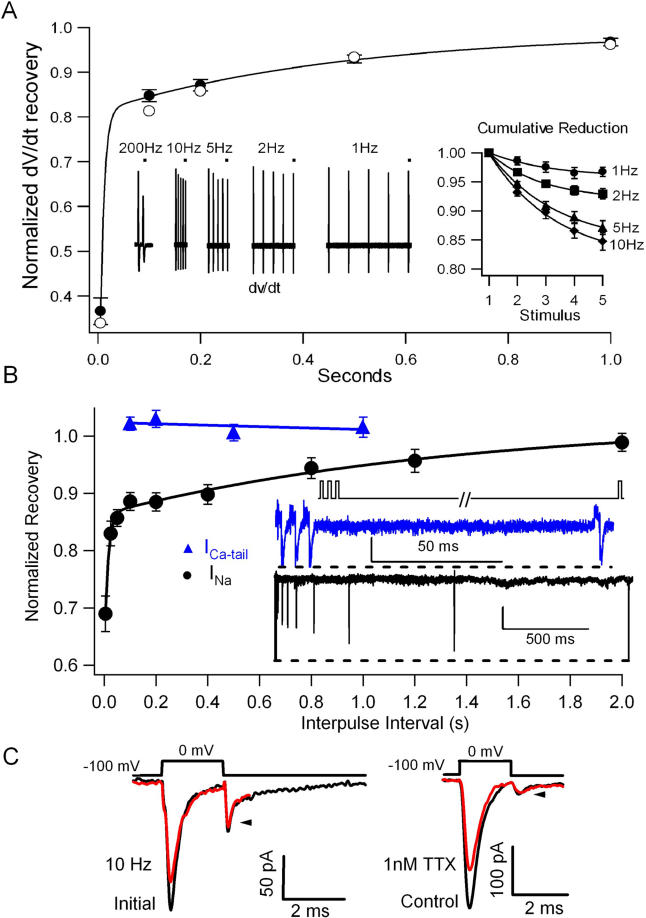
Transitions from Bursting to Single Spiking Output Are Mediated by Slow Recovery from Na+ Current Inactivation(A) Filled black circles show the dV/dt of the first action potential response to the fifth suprathreshold sEPSC input at frequencies between 1 and 10 Hz (n = 14; open circles, 5 mM BAPTA, n = 3; recorded at 34 °C). The inset shows a cumulative decrease in the action potential rise rate (dV/dt) (τ1Hz = 17,980 ms, τ2Hz = 925 ms, τ10Hz = 250 ms; n = 14).(B) Recovery from burst-induced (two or three step pulses [2 ms] from −100 mV to 0 mV) inactivation of Na+ current (black, n = 11 cell-attached patches) and Ca2+ current (blue; n = 9 [pooled cell attached, n = 4, and nucleated patches, room temperature, n = 5]). The inset shows examples of the burst-induced slow inactivation of Na+ current (black, vertical scale bar is 50 pA) and the lack of slow inactivation of the Ca2+ tail current (blue, vertical scale bar is 5 pA). I
Na (black) is an overlay of multiple traces, each with an initial burst-like current followed by a single test pulse at different recovery intervals.(C) The left tracing shows a nucleated outside-out patch recording (at room temperature) comparing Na+ current in response to a single step pulse (2 ms) in control (black) or 100 ms (10 Hz) after burst conditioning (red). Arrowhead shows the lack of reduction in the I
Ca (tail). The right tracing shows a reduction of the Na+ current without a change in the I
Ca (tail) after bath application of 1 nM TTX (black, control; red, TTX). Values are reported as mean ± standard error of the mean.